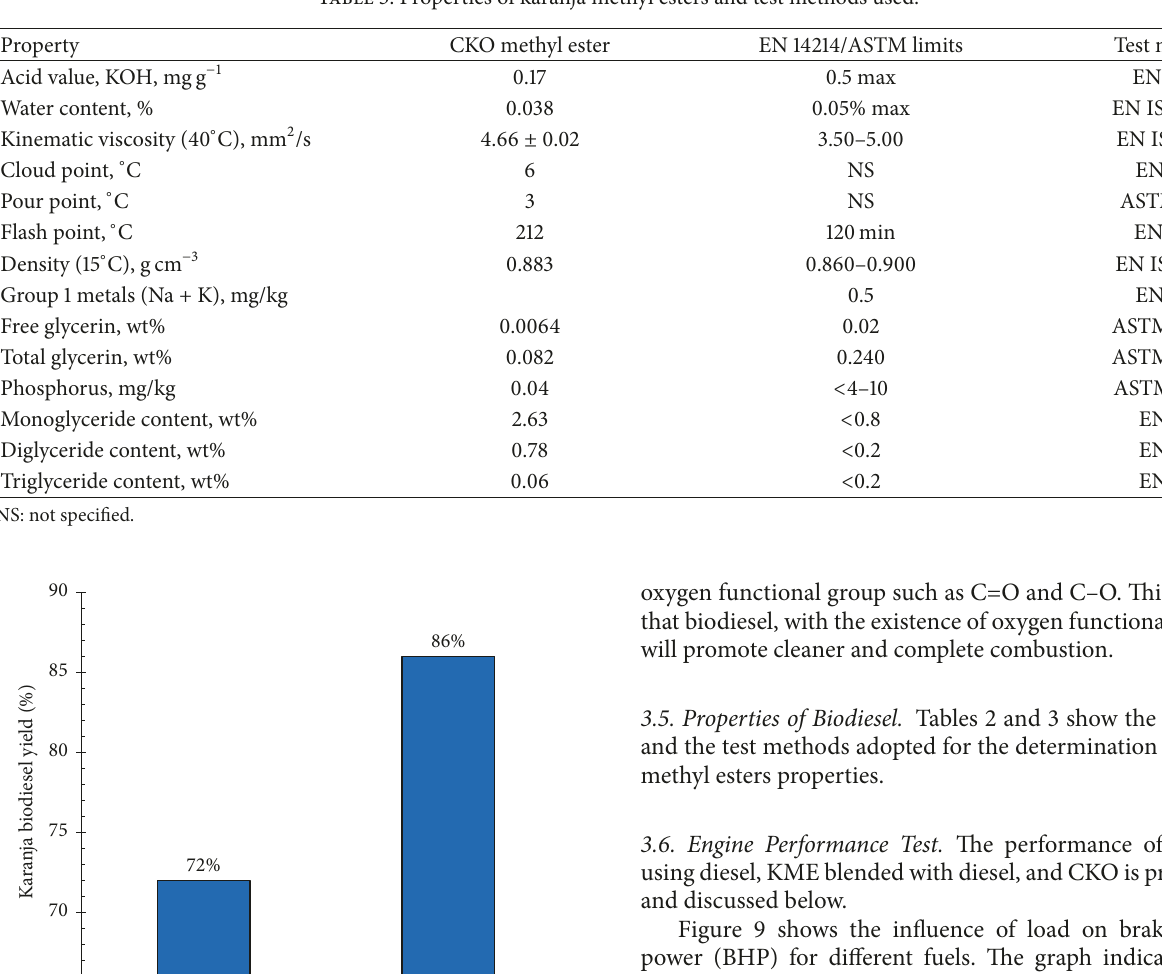
Table 3: Properties of karanja methyl esters and test methods used.